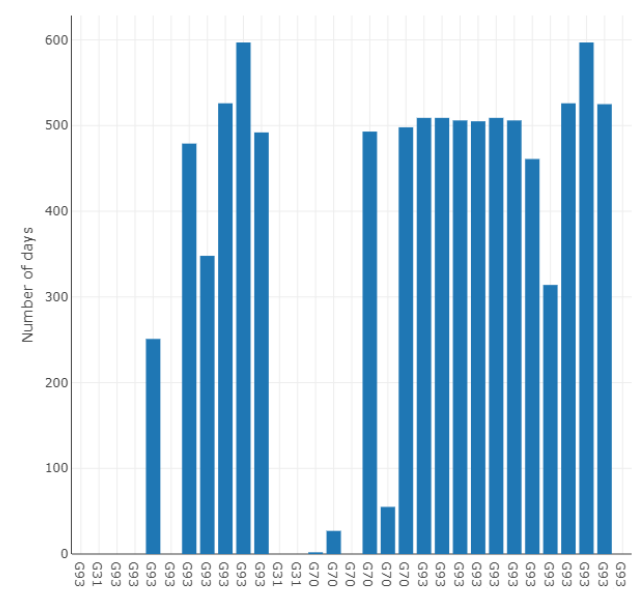
Figure 12. Distribution of whole data samples in terms of day.